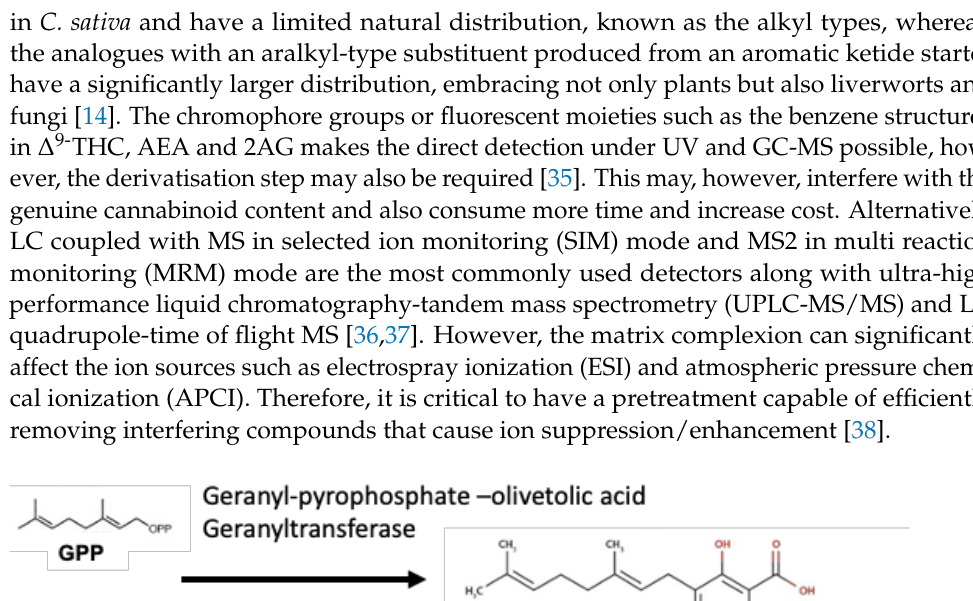
Table 1. Phytocannabinoid classes.